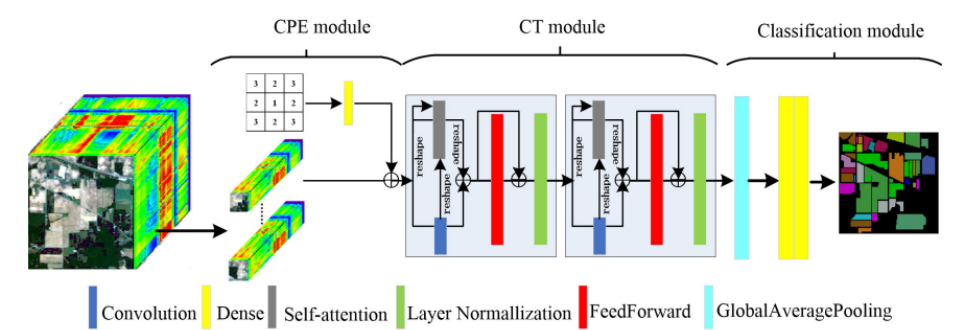
Figure 10. Overview of the CTN framework [10] for hyperspectral image classification. Given the HSI data patches, CTN processes them to center position encoding (CPE), convolutional transformer and classification modules. Here, the output represents the category label. Figure is from [10]. Best viewed zoomed